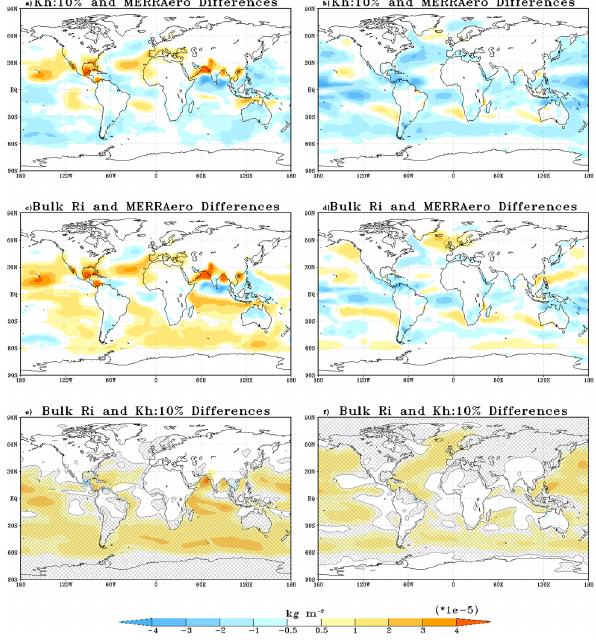
Figure 16. Seasonal mean column sea salt differences. Method 2 minus MERRAero for JJA (a) and DJF (b) , Method 3 minus MER- RAero for JJA (c) and DJF (d) , and Method 3 minus Method 2 for JJA (e) and DJF (f) . Hatch marks on the bottom plots represent sig- nificance at the 90% level using the Student’s t test. Crosshatch marks represent significance at the 95%